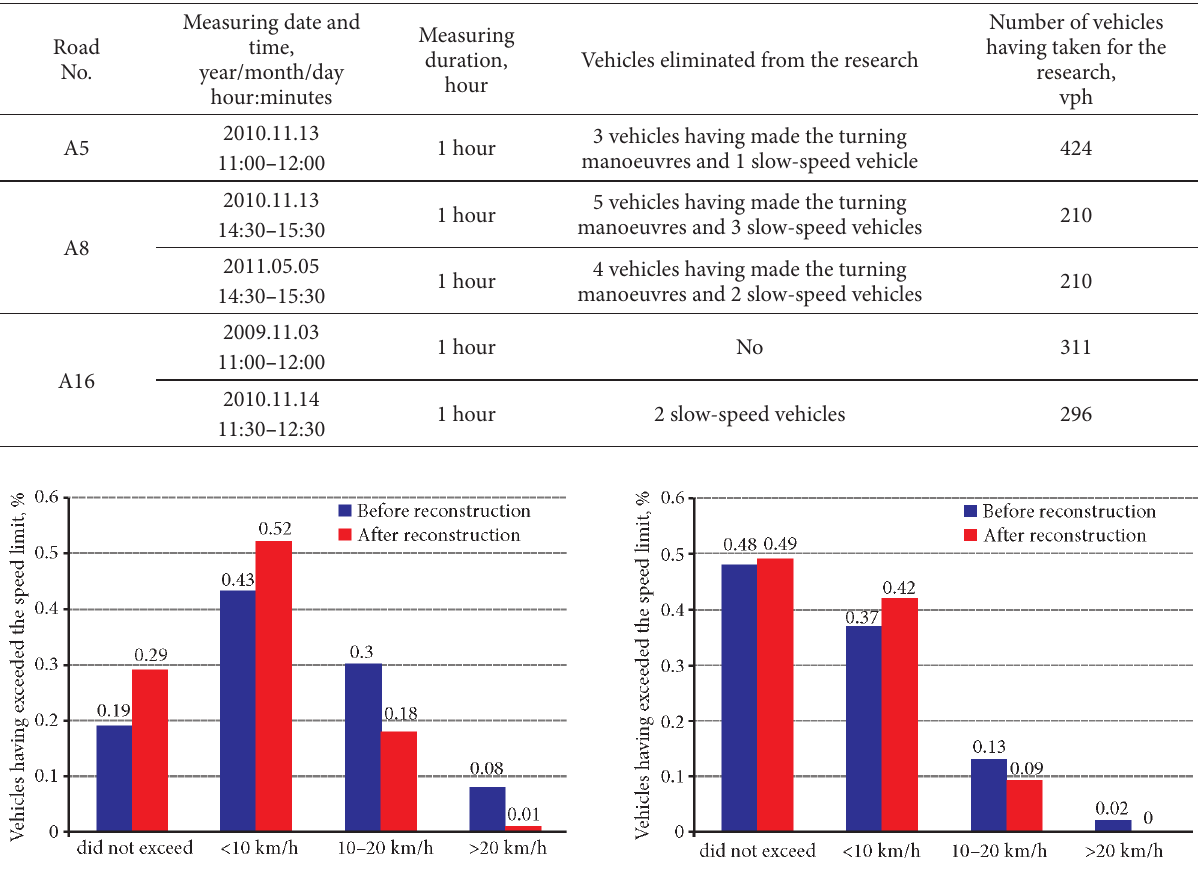
Vehicles eliminated from the research